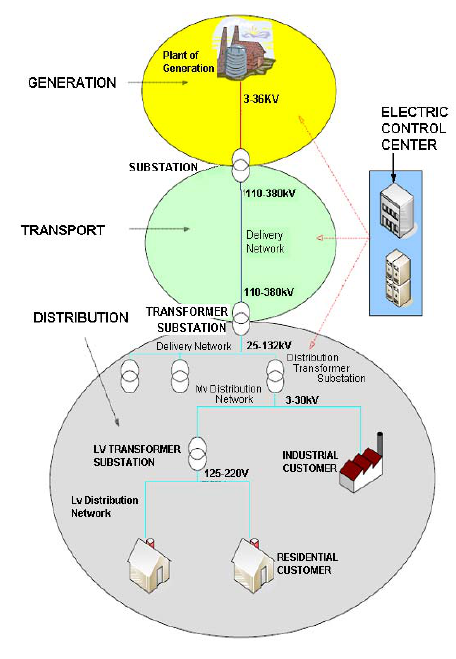
Figure 1. Electric Power Supply